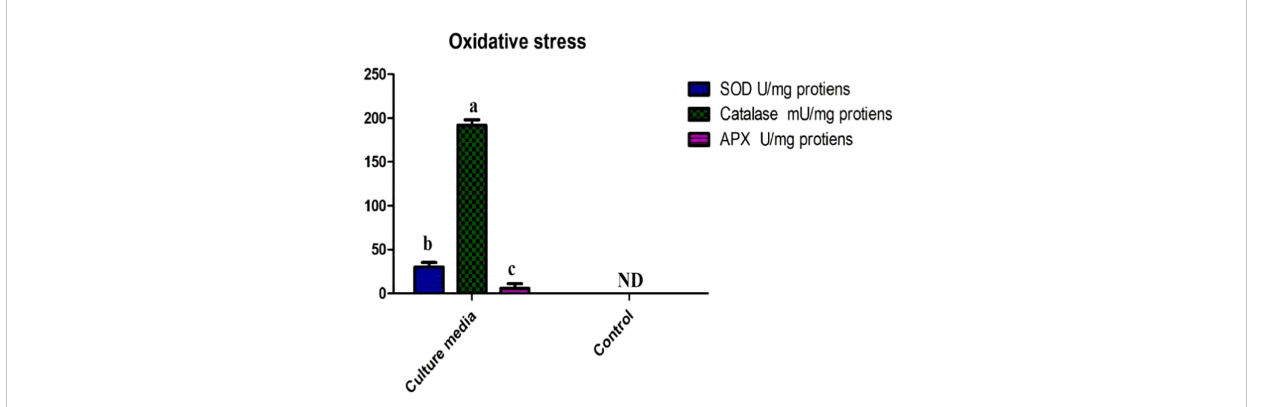
FIGURE 7 Effect of various concentrations of PEG 6000 and biopriming with SH-8 on the seed vigor index, germination rate index, germination energy, and germination potential of wheat seeds. PEG, polyethylene glycol. Different lowercase letters indicate signi fi cant difference in